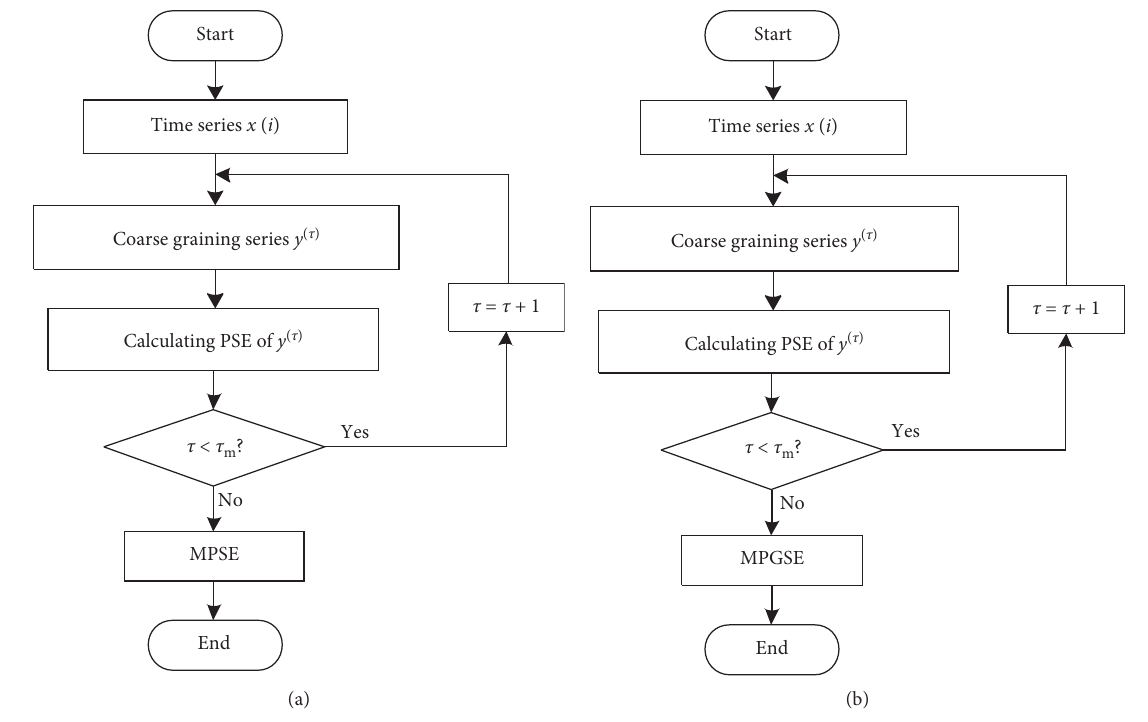
Figure 6: Flowchart of (a) MPSE and (b)